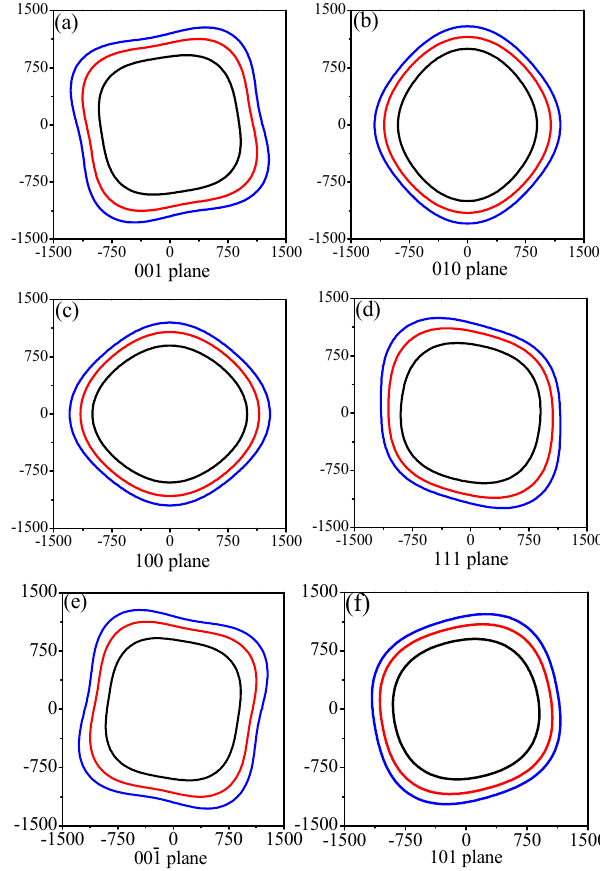
Figure 6. 2D representation of Young’s modulus in the (001), (010), (100), (111), (001 ), and (101) planes for I4 –carbon, shown in ( a – f ), respectively.